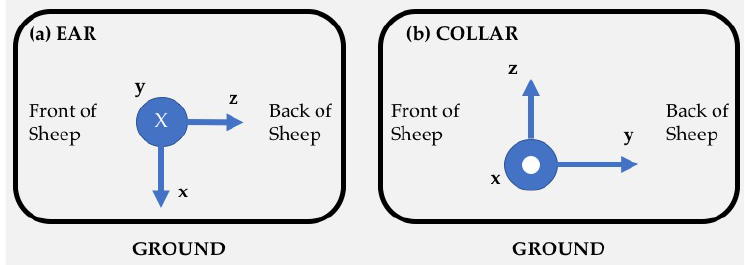
Figure 1. Sensor orientations for ( a ) ear and ( b ) collar mount configurations.